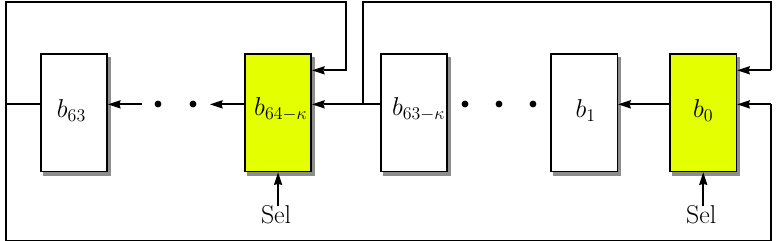
Figure 2: Shift register circuit with ( κ -respecting) 2 scan